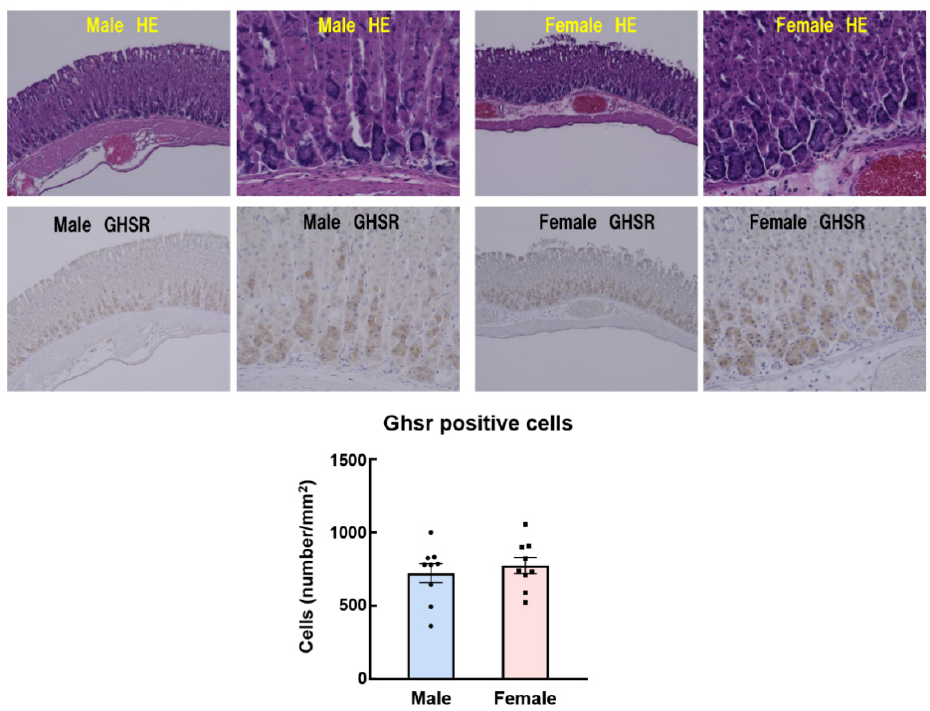
Figure 3. Immunohistochemical staining of Ghsr positive regions in the gastric mucosa and number of Ghsr positive cells among gastric chief cells. The upper row shows hematoxylin eosin (HE) staining, and the lower row shows Ghsr stained (Anti-Ghrelin Receptor antibody ab95250, abcam) photographs. The figure shows the number of positive cells per mucosal region (mm 2 ). n = 9.